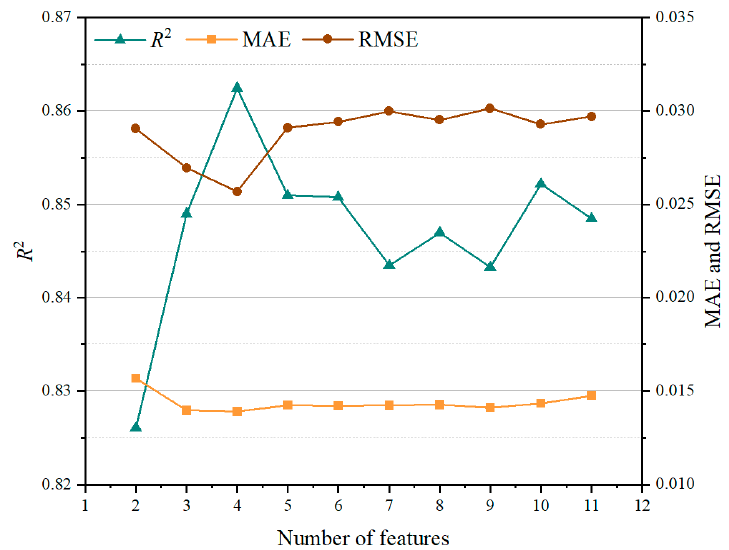
Figure 3. The performance of the model in the optimal hyperparameter with different feature combinations as input.